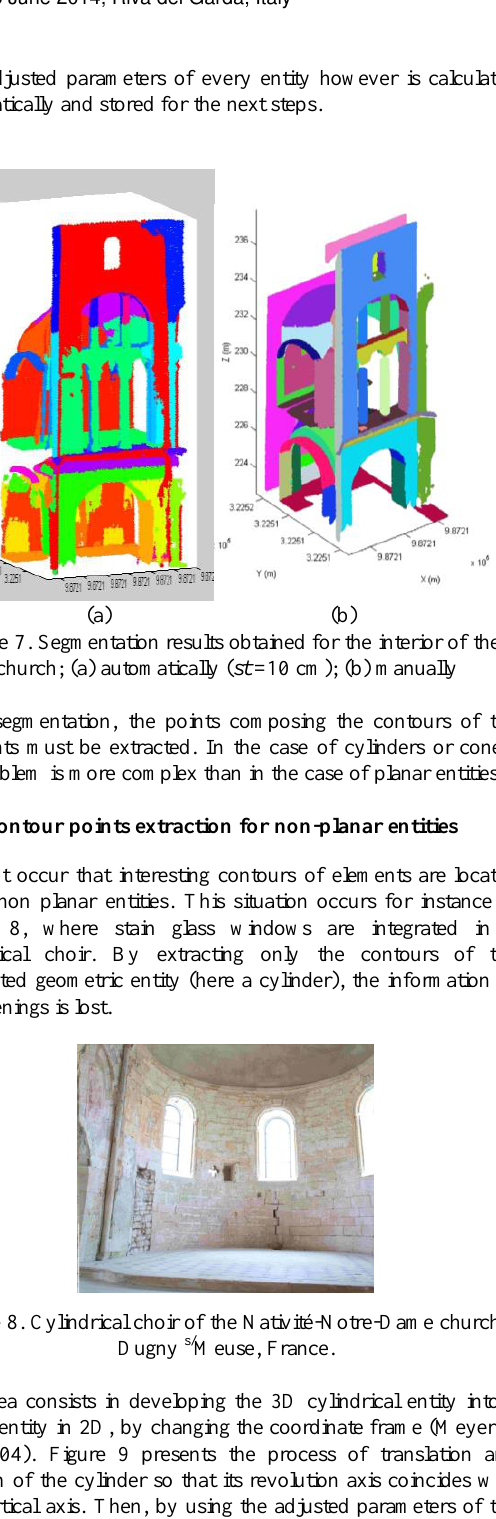
Figure 6. Segmentation results obtained for the point cloud of the exterior of the church (one color per entity) For experimenting the process inside the church, a sample of the point cloud has been considered (see pink frame in Fig. 5). It refers to a portion of about 6 m large x 15 m high x 8 m depth.